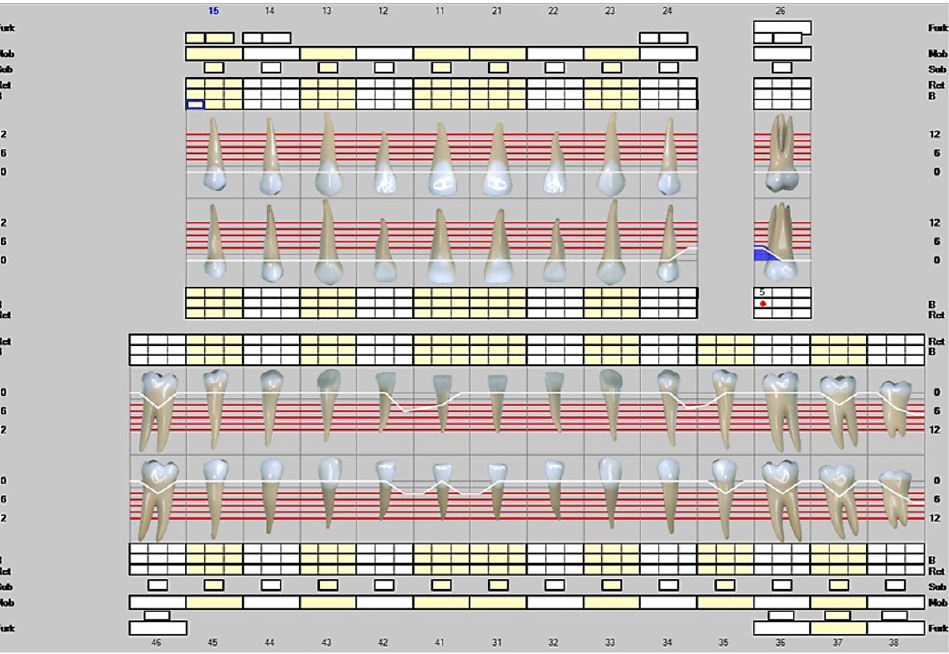
Figure 4. Representation of the clinical situation on 25 May 2022. The white line describes the clinical attachment level and the blue color infected periodontal pockets. The red dots represent a positive result in bleeding on probing.